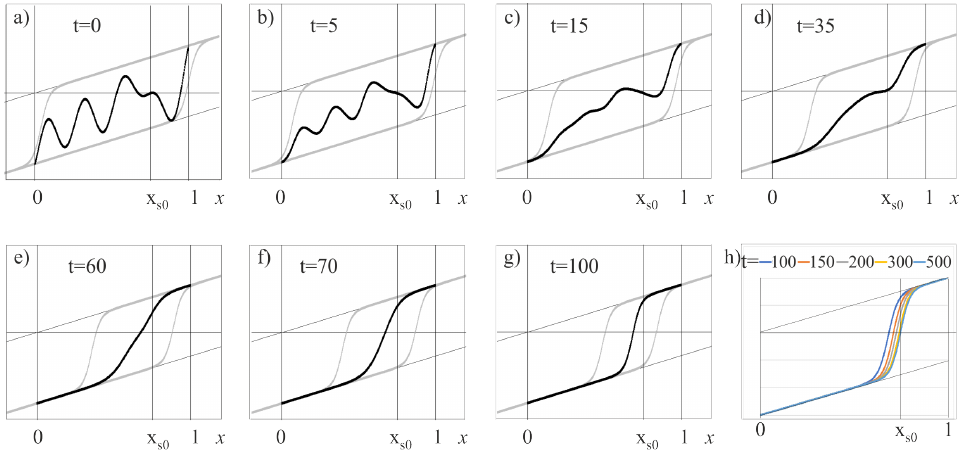
Figure 1. ( a – g ): the numerical solution of problem (51) (solid black bold line) and location of the upper and lower solutions (solid gray bold lines) at different moments of time; ( h ) the illustration of solution stabilization over time. Thin oblique straight lines denote the reduced equation solutions ϕ ( − ) = x − 1.5 and ϕ (+) = x